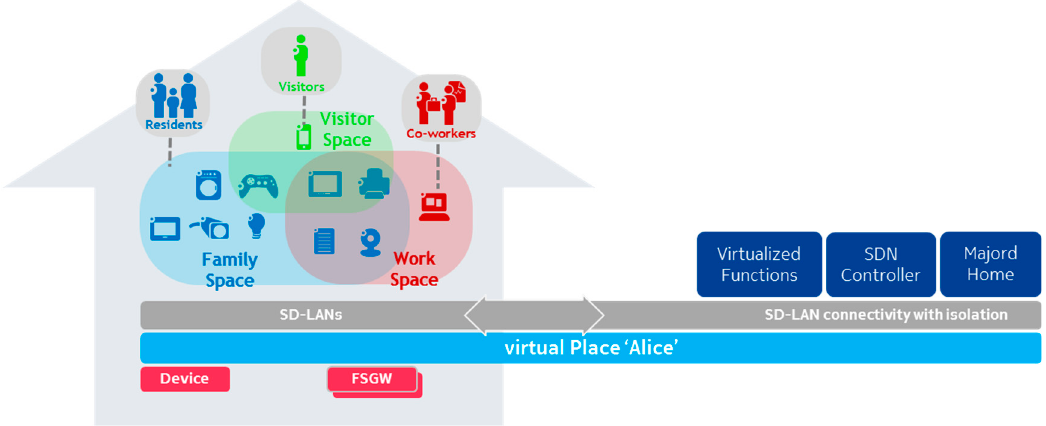
Figure 2. Key functional elements of a vPlace.